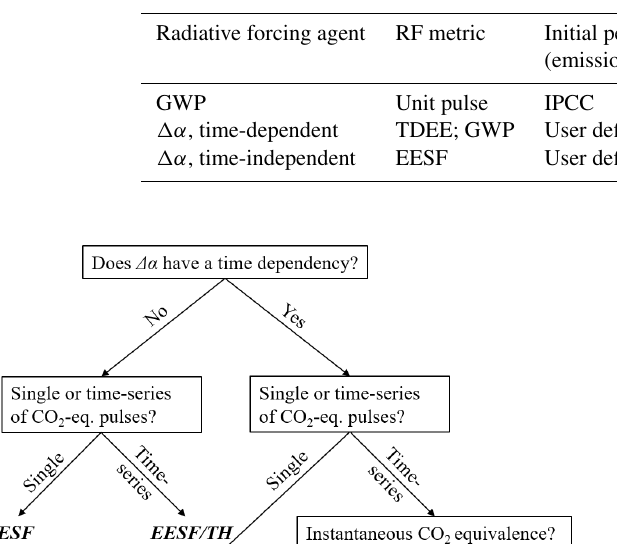
Table 2. Important decisions required by the practitioner to obtain a CO 2 -eq . metric for (cid:49) α (based on RF) relative to conventional CO 2 - normalized emission metrics of the IPCC (i.e., GWP).